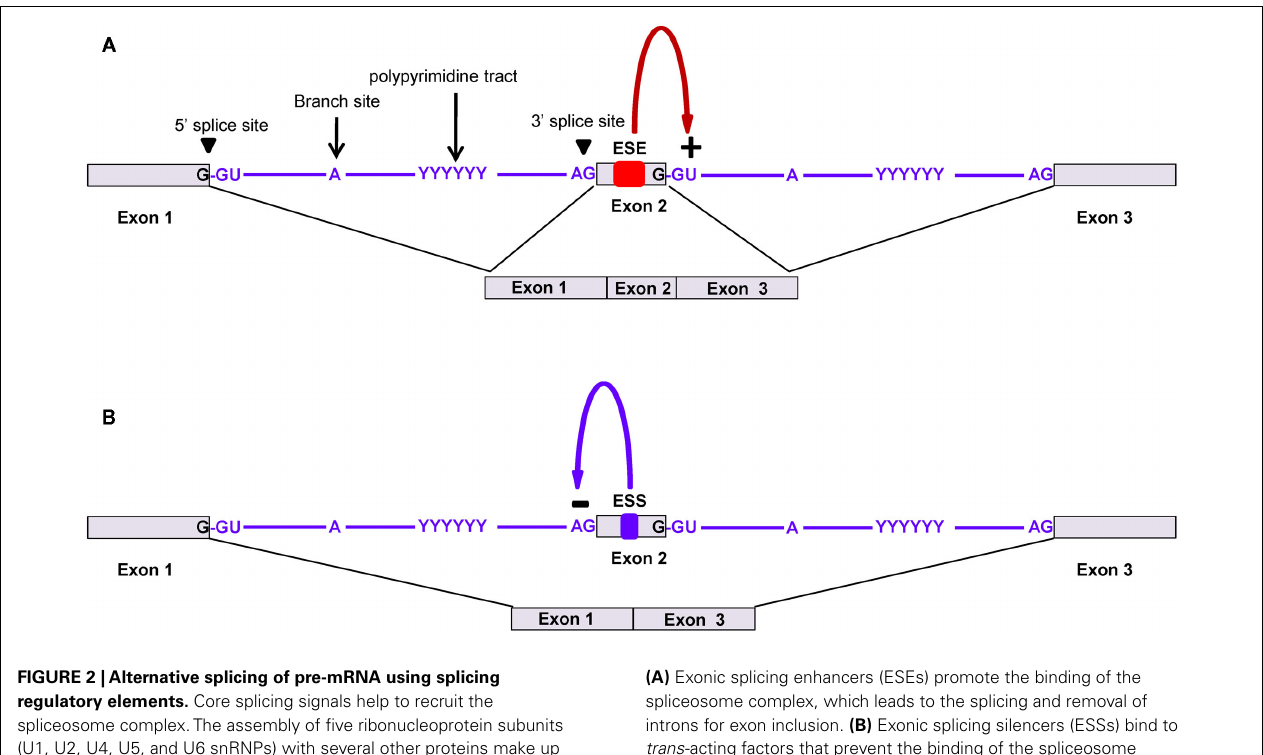
FIGURE 2 |Alternative splicing of pre-mRNA using splicing regulatory elements. Core splicing signals help to recruit the spliceosome complex.The assembly of five ribonucleoprotein subunits (U1, U2, U4, U5, and U6 snRNPs) with several other proteins make up the spliceosome, which catalyzes the splicing and ligation of